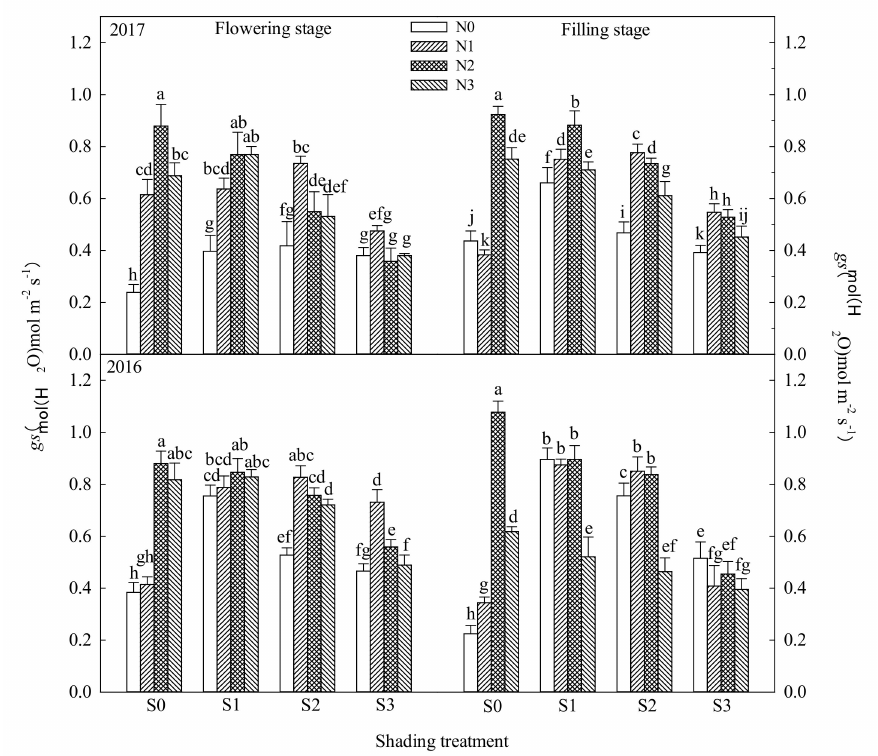
Figure 4. Effect of light and nitrogen treatment on the stomatal conductance (gs) of wheat. Bars indicate SD (n = 3). Values within columns followed by the same letter are statistically insignificant at the 0.05